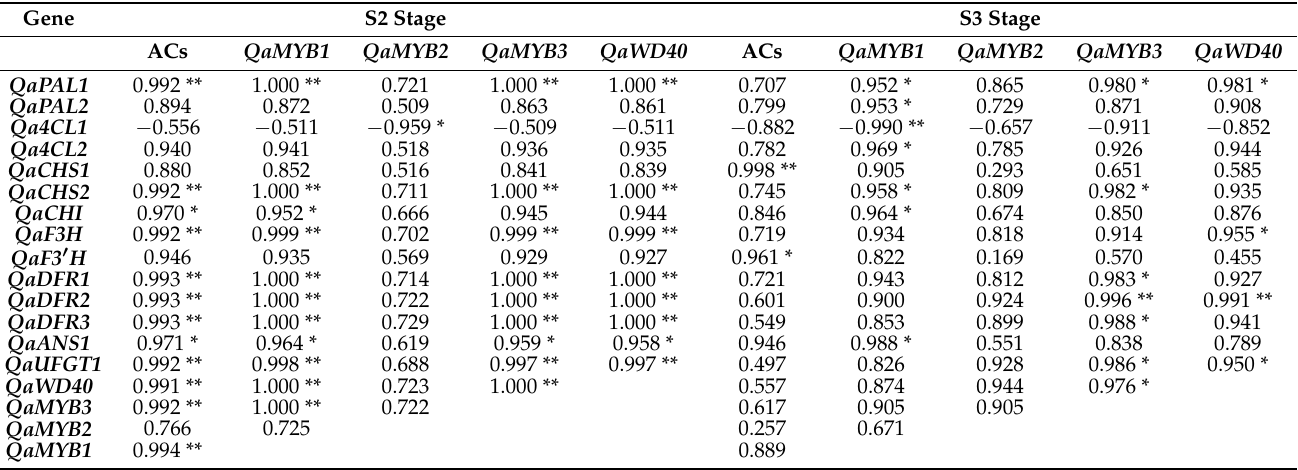
Figure 5. Analysis of cis-acting elements for anthocyanin synthesis-related genes in Q. aliena . ( a ) Plant hormone responsive elements; ( b ) environment responsive elements; ( c ) MYB and bHLH transcription factors binding elements. Table 2. Correlation analysis comparing anthocyanin content and anthocyanin synthesis-related gene expression in Q. aliena accessions.